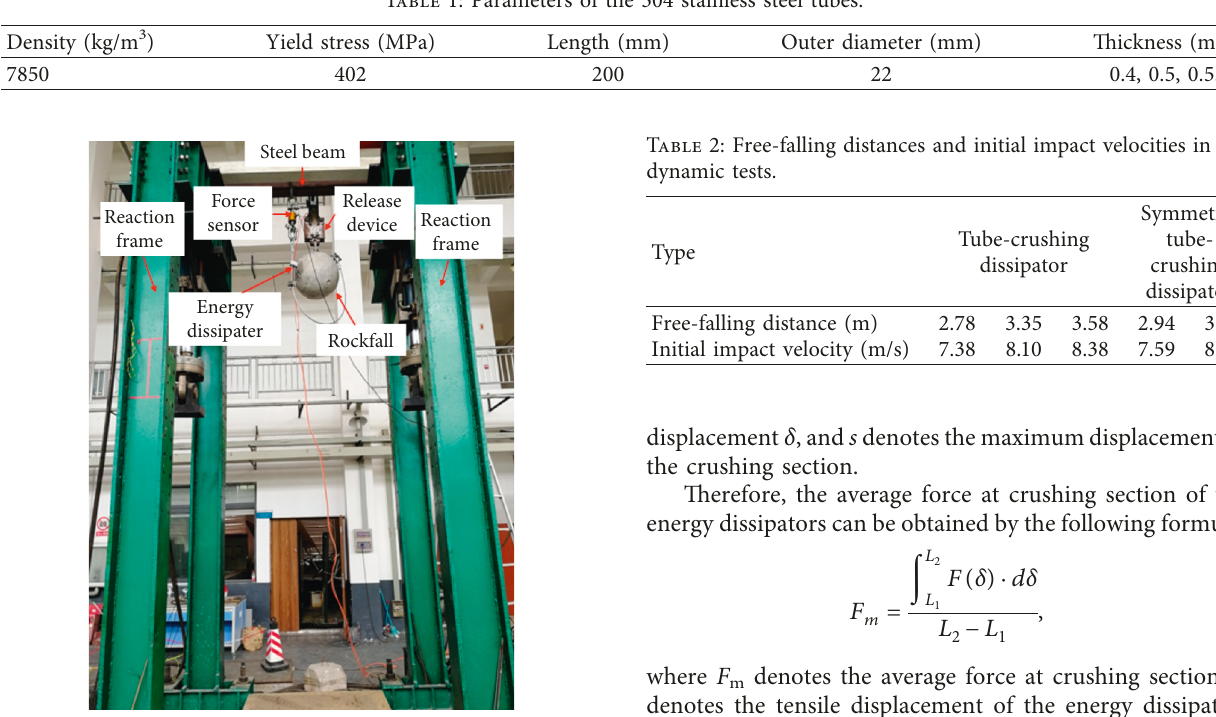
Figure 5: Experimental setup of the dynamic tests.